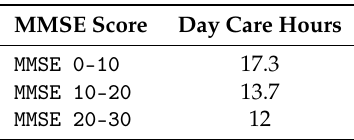
Table 3. Day care